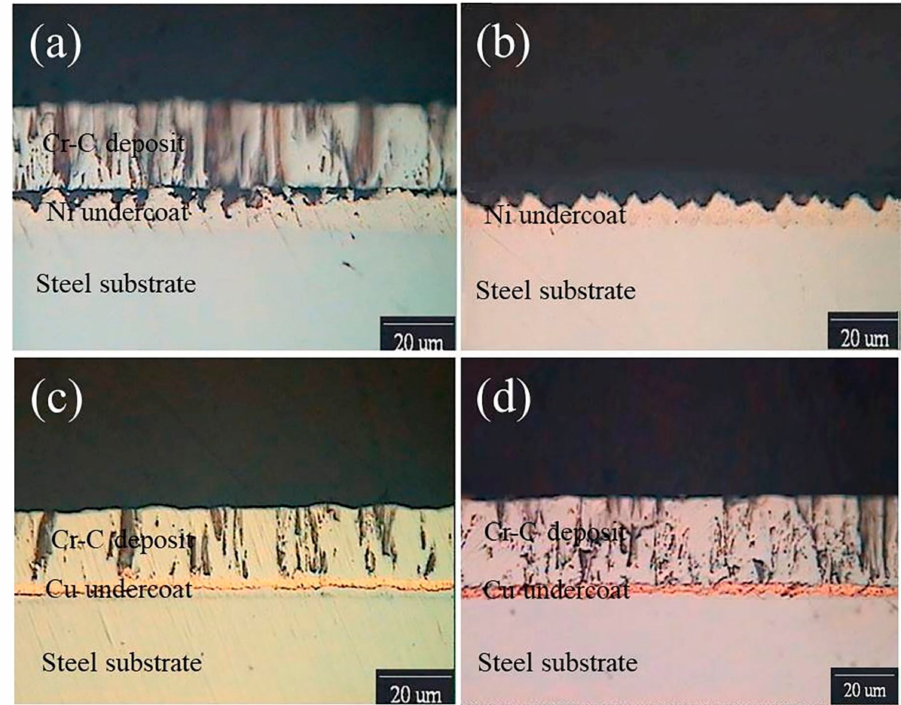
Figure 6. Cross-sectional micrographs of the ( a ) non-heated and ( b ) heat-hardened Cr–C / Ni-coated samples and those of the ( c ) non-heated and ( d ) heat-hardened Cr–C / Cu-coated d samples after two-hour potentiostatic etching at 0